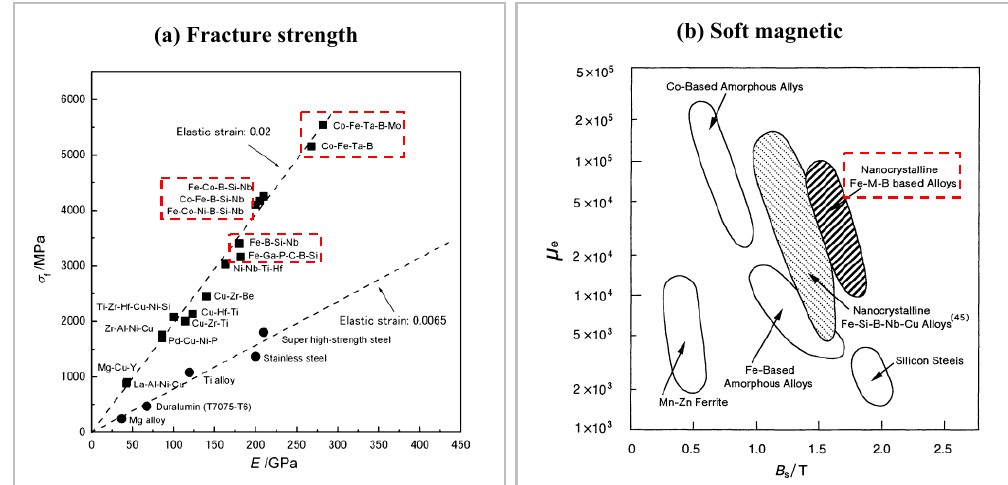
Figure 6. ( a ) Fracture strength of amorphous alloys, adapted with permission from Ref. [7] 2000, Elsevier. ( b ) Comparison of magnetization strength Bs and permeability μ c of amorphous alloys with various soft magnetic materials (1 kHz) [55].